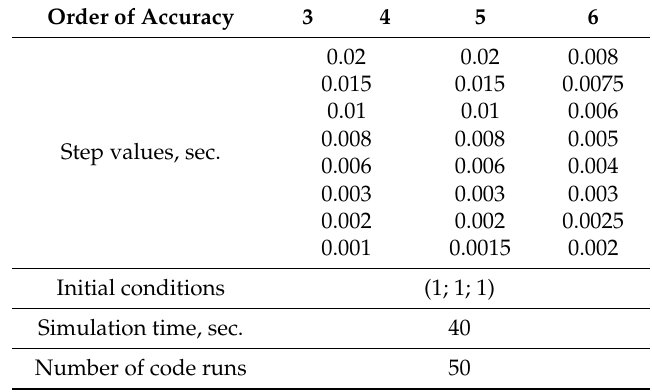
Table 3. Parameters used with the experiments with the Rossler